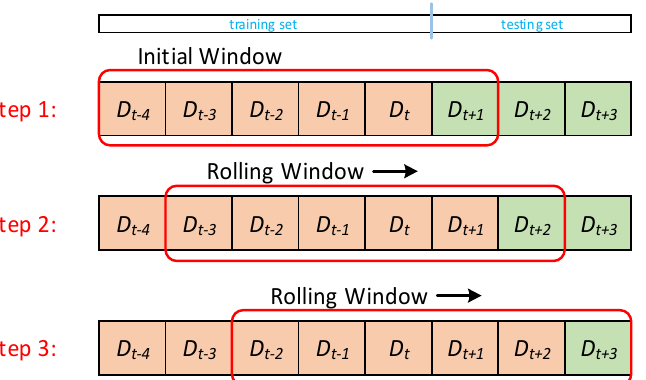
Figure 2. The proposed RNN-based ensemble method. Figure 3. A three-day ahead rolling window technique. Figure 3. A three-day ahead rolling window technique.